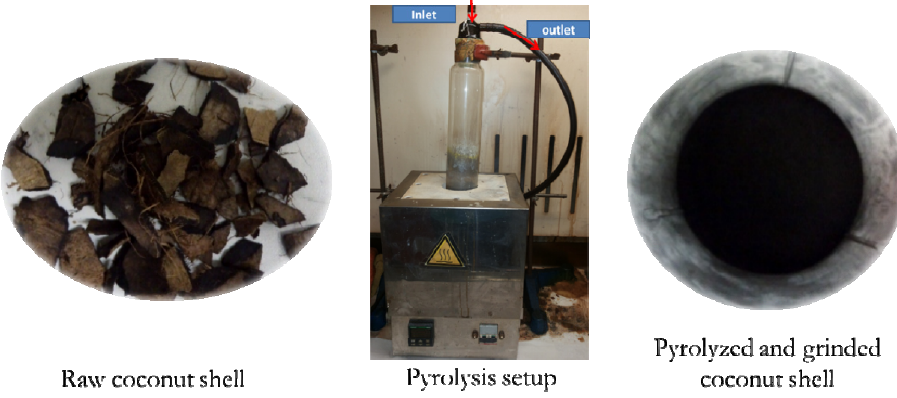
Figure 1: Synthesis of micro carbonized particles from coconut shell by